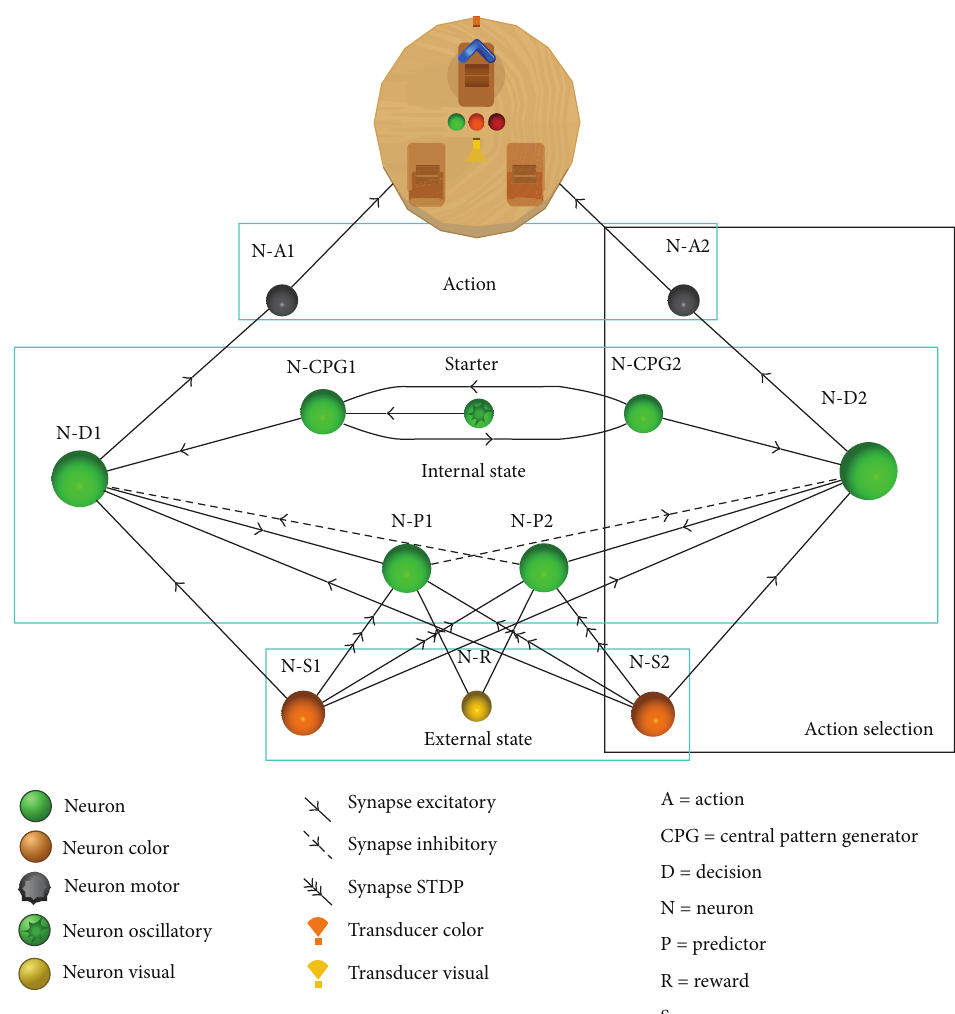
Figure 3: Generic SNN of AS and OC in a two-sensor and two-motor